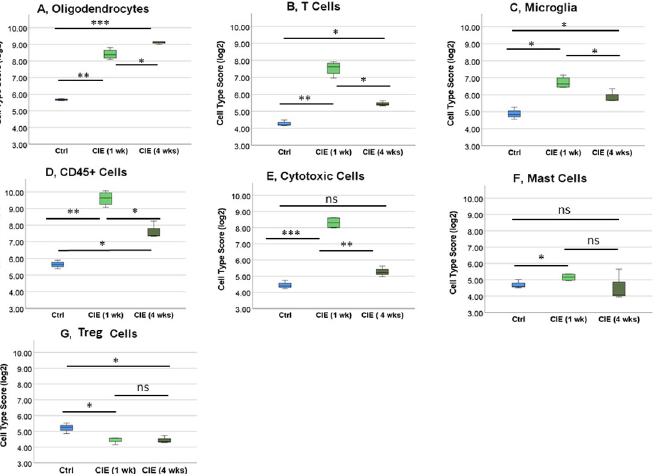
Fig 3. Clustering of the SC genes based on their expression level in different cell types. Cell type scores were significantly different between the control and experimental groups for several populations of the cells including oligodendrocytes (A), T cells (B), microglia (C), CD45+ cells (D), cytotoxic cells (E), mast cells (F), and Treg cells (G). n = 4 for CIE 1 wk group, n = 3 for CIE 4 wks and control groups. � p � 0.05, �� p � 0.01, ��� p � 0.001.